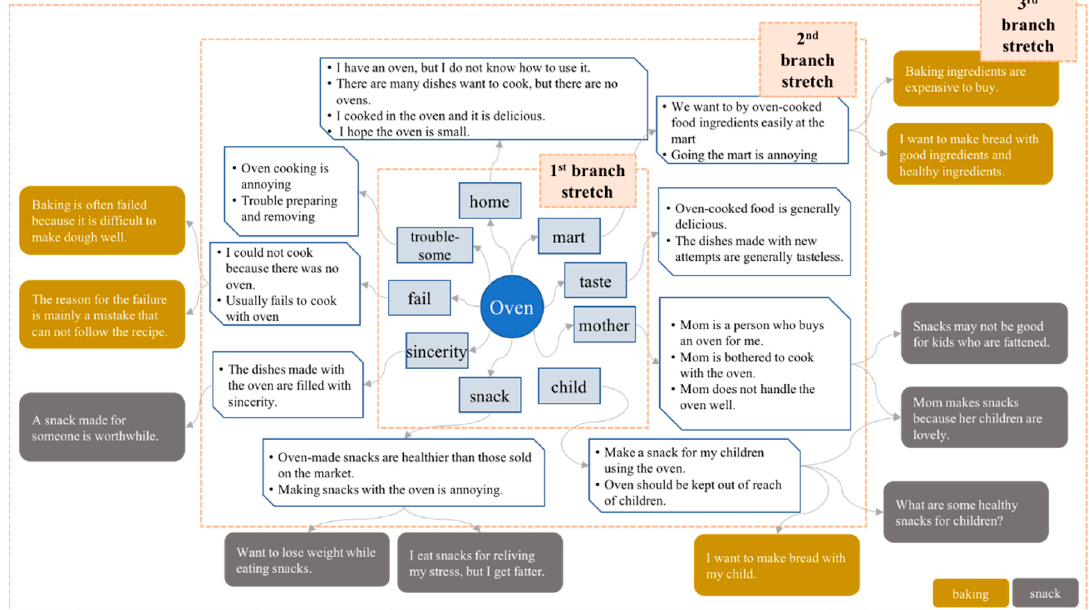
Figure 8. Context Tree for the primal keyword ‘oven’.